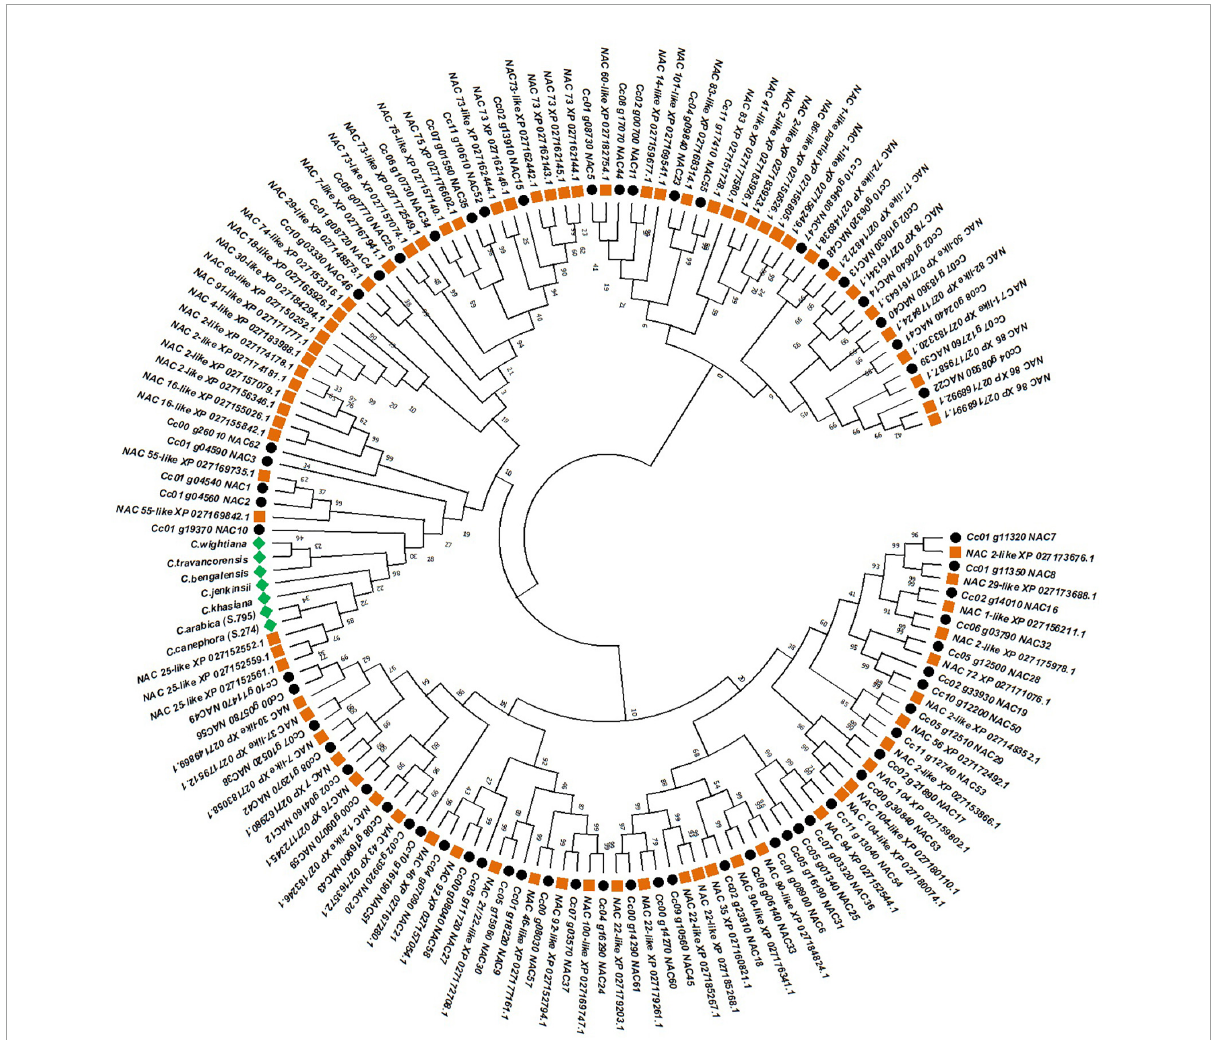
FIGURE3 Phylogenetic tree constructed by using 81 different classes of NAC protein sequences of C. eugenioides (orange squares), 63 different classes of NAC protein sequences of C. canephora (black circle) and the NAC protein sequences isolated in the present study (green square) using Maximum Likelihood approach